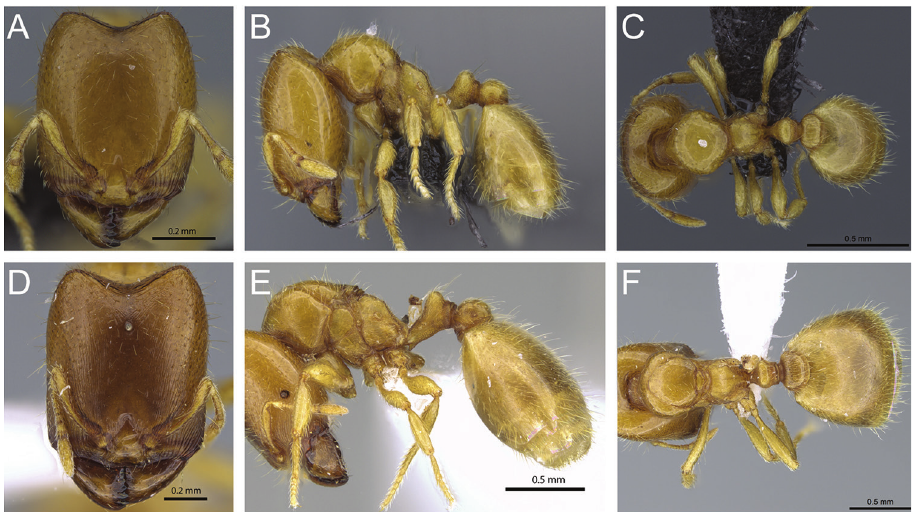
Figure 51. Intermediates of Carebara malagasy . Major workers, CASENT0141887: A head in full-face view B body in profile view C body in dorsal view. CASENT0438154: D head in full-face view E body in profile view F body in dorsal C. malagasy have two intermediates in the major worker subcaste (Figure 51). The posterolateral corner of head in both intermediates is slightly narrowed posteriorly. The posterior margin of the head is deeply concave. The eyes are small and reduced to one ommatidium in intermediate 1, and up to 5 ommatidia in intermediate 2. Ocelli are absent in intermediate 1, but present and well developed in intermediate 2 (one ocel- lus). Reduced flight sclerites are present in intermediate 2. The dorsum of the prome- sonotum is high and nearly rounded in intermediate 1, and convex in intermediate 2.